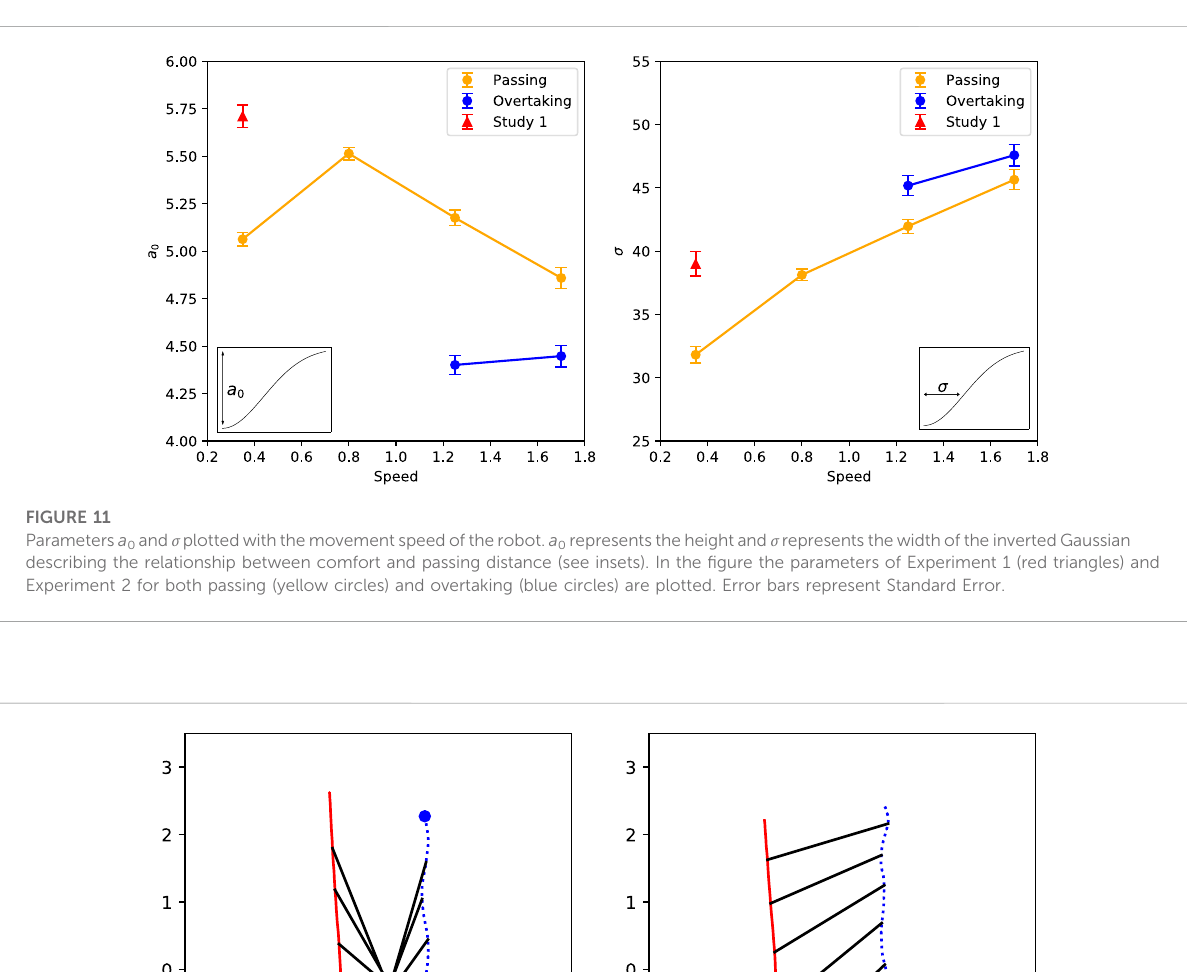
of 5 m for the robot, this is not a large deviation. It slightly changes the actual passing distances and shifts the curves in Figure 10 a bit, but it would not change the effect of our manipulations.